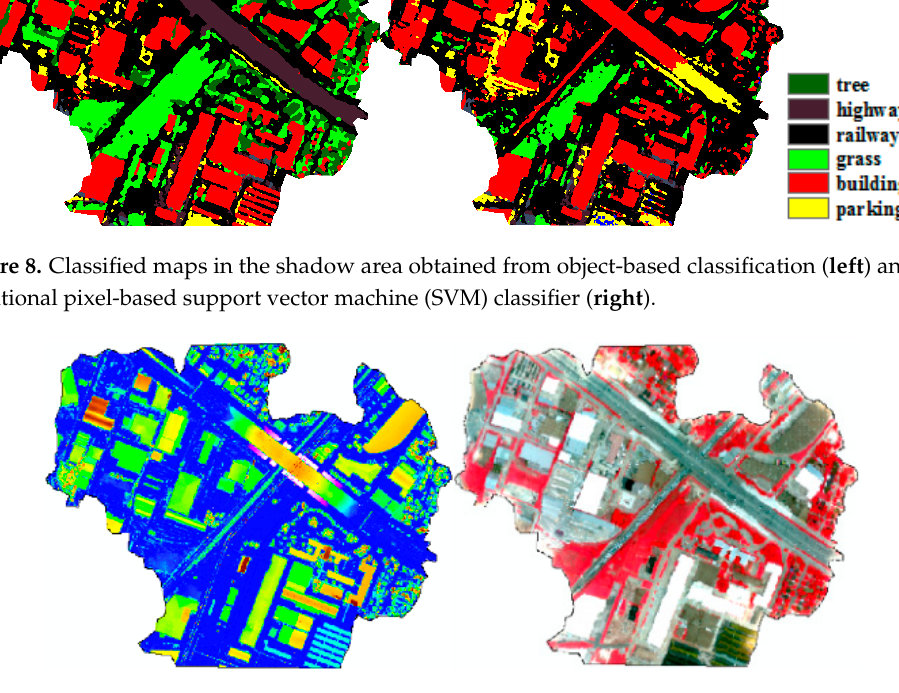
Figure 9. The nDSM imagery of the cloud shadow area ( left ) and the hyperspectral data of the cloud shadow area ( right ).